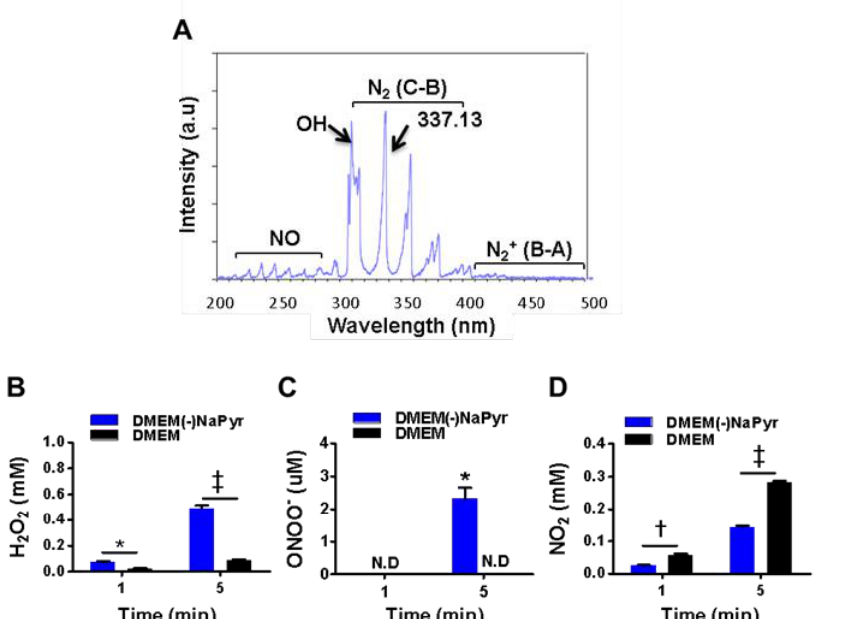
Figure 2. Optical emission spectra (OES) of a plasma jet with N 2 gas and H 2 O 2 , ONOO − and NO 2 in two concentrations of DMEM with or without NaPyr exposed to plasma. ( A ) Optical emission spectra of plasma jet at 200–500 nm. ( B – D ) Assessment of H 2 O 2 , ONOO − , and nitrite (NO 2 − ) concentrations in DMEM with or without NaPyr exposed to NTPJ for 1 and 5 min. N.D: not detected; * p < 0.05, and † p < 0.01, and ‡ p < 0.001, DMEM vs. DMEM(-) NaPyr. All error bars represent the mean ± standard deviation; n = 3.